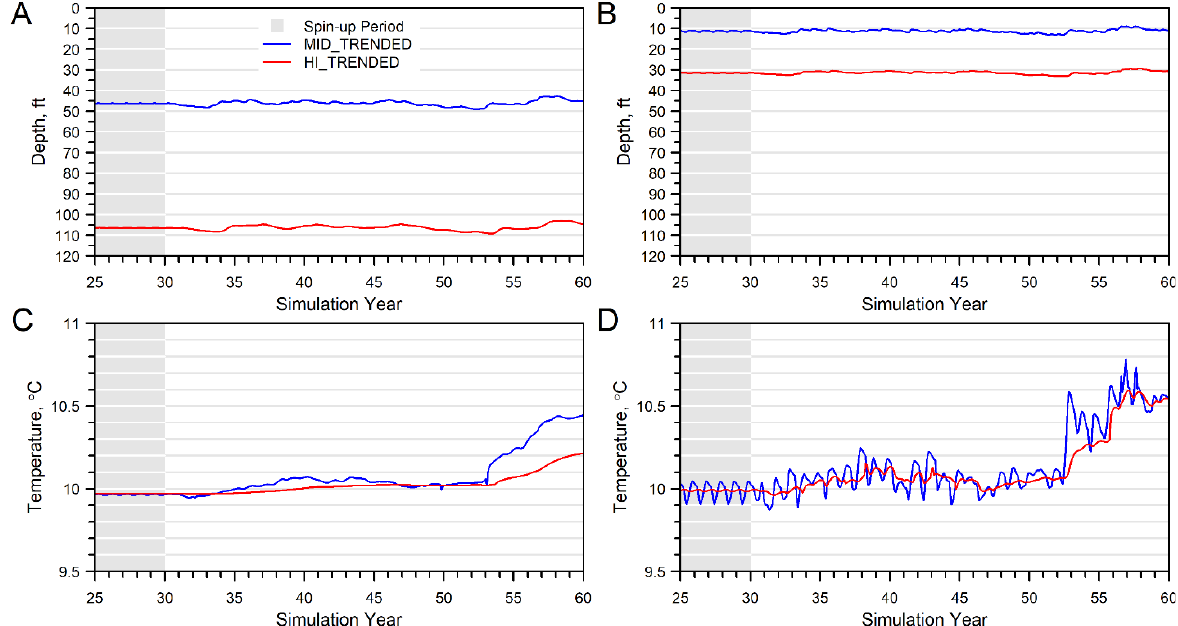
Figure 6. Time-series results for Synthetic Model at Upland and Valley Locations: ( A , B ) Depth to water table for MID_TRENDED and HI_TRENDED simulations; ( C , D ) Water table temperature for MID_TRENDED and HI_TRENDED simulations. Upland and Valley locations are shown in Figure 3. Warming period begins in Simulation Year 30.